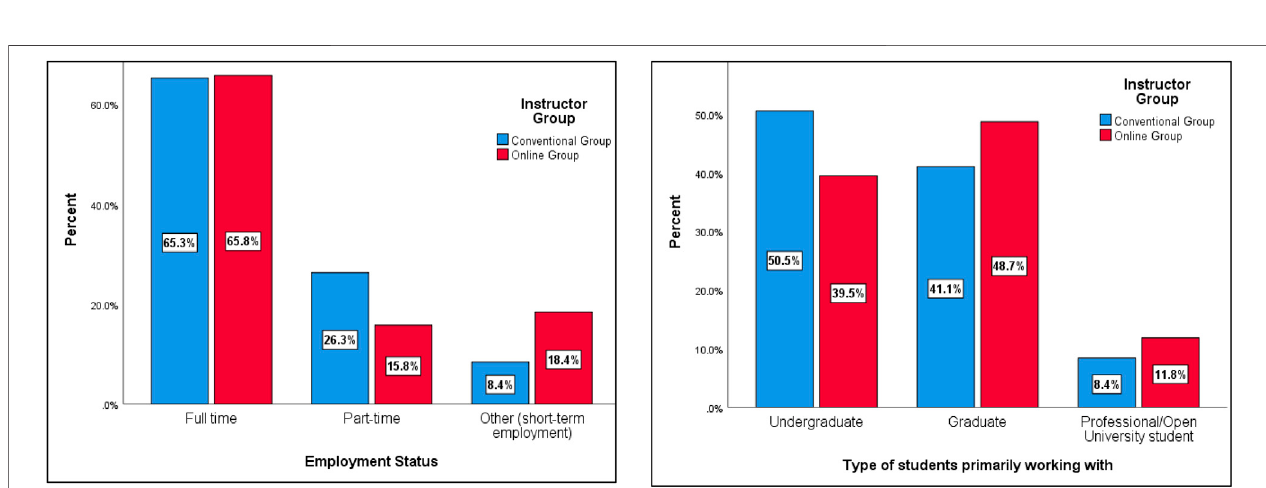
FIGURE 2 | Employment Status ( Figure 2-left ) and level of students instructors in the Online Group and the Conventional Group primarily worked with ( Figure 2- right